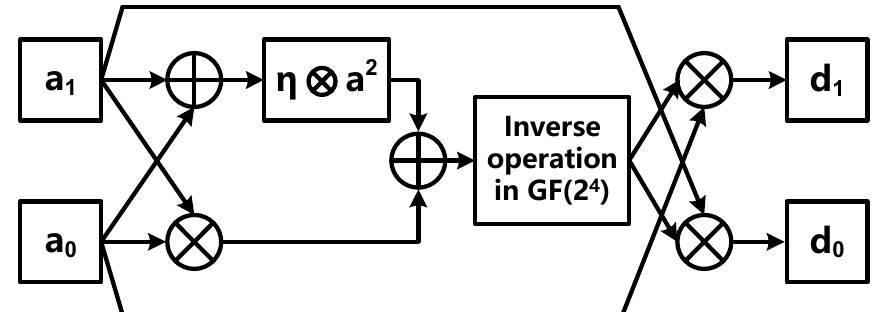
Figure 8. Multiplicative inverse operation of GF(2 4 ) based on regular basis. In GF(2 2 ), the multiplicative inverse operation is the same as the square operation. When regular basis is used, the multiplicative inverse operation can be further calculated as: (𝑐 (cid:2869) 𝑊 (cid:2870) + c (cid:2868) W) (cid:2879)(cid:2869) = (𝑐 (cid:2869) 𝑊 (cid:2870) + c (cid:2868) W) (cid:2870) = (𝑐 (cid:2868) 𝑊 (cid:2870) + c (cid:2869) W) (8) in which way the multiplicative inverse operation in the GF(2 2 ) field can be easily imple- mented in bit-wise logic operations as mentioned previously. Table 5 shows the hardware overhead of S-Boxes based on LUT and GF in a 65-nm ASIC implementation. It can be found that the S-Box based on GF(((2 2 ) 2 ) 2 ) field implemen- tation can save hardware overhead by more than 30% against the LUT implementation. Table 5. Hardware overhead of S-Boxes based on LUT and GF(((2 2 ) 2 ) 2 ) in 65-nm ASIC implementa- tion. Algorithm Type